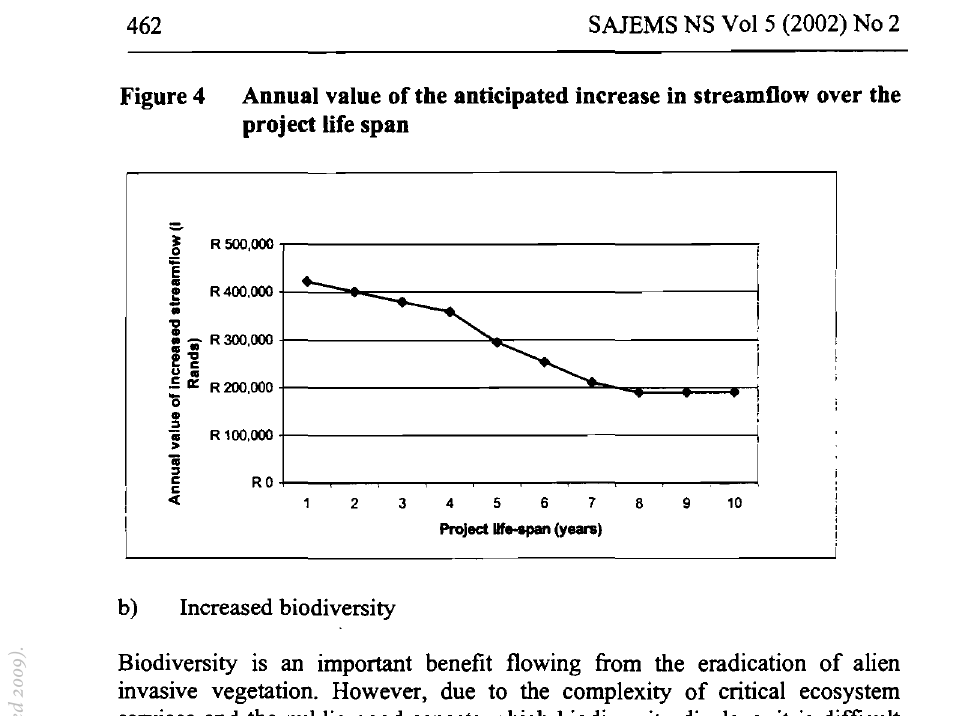
Annual value of tbe anticipated increase in streamflow over tbe project life